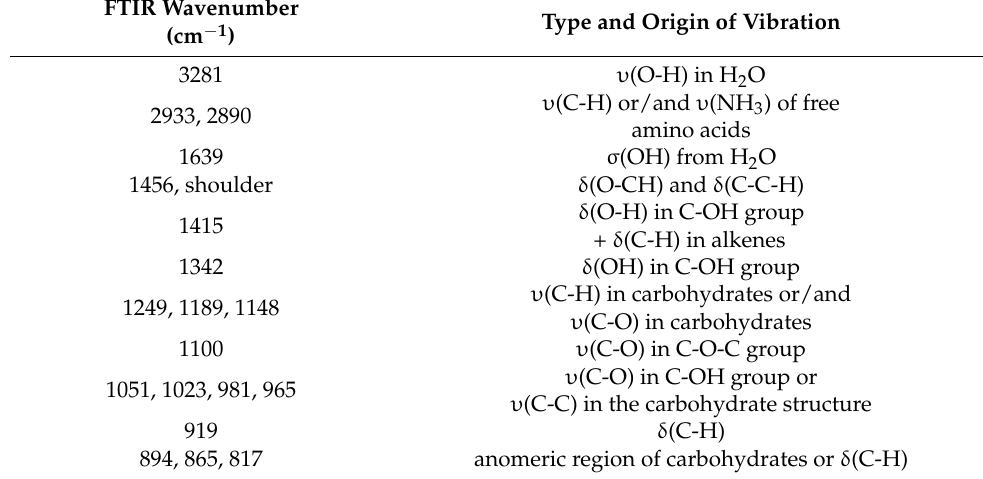
Table 2. Assignment of absorption peaks of the FTIR spectra from